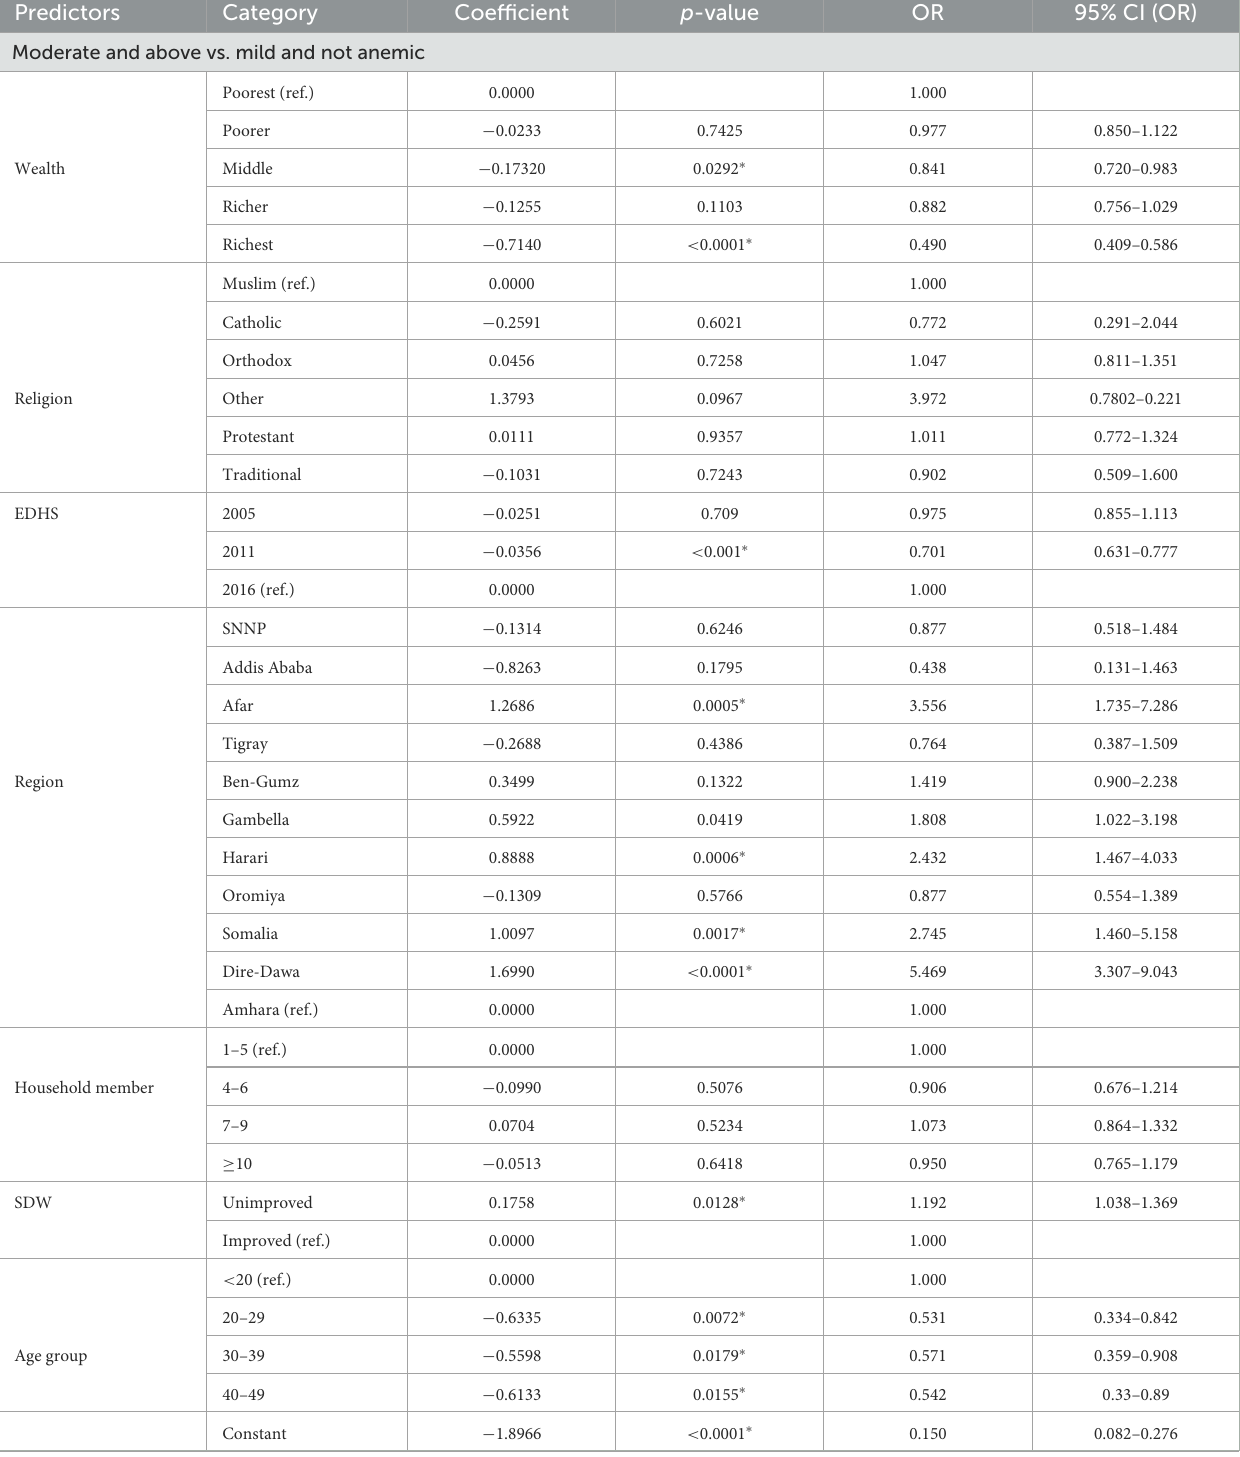
TABLE 6 Maximum likelihood estimates of partial proportional odds model. Predictors Category Coefficient p -value OR 95% CI (OR)